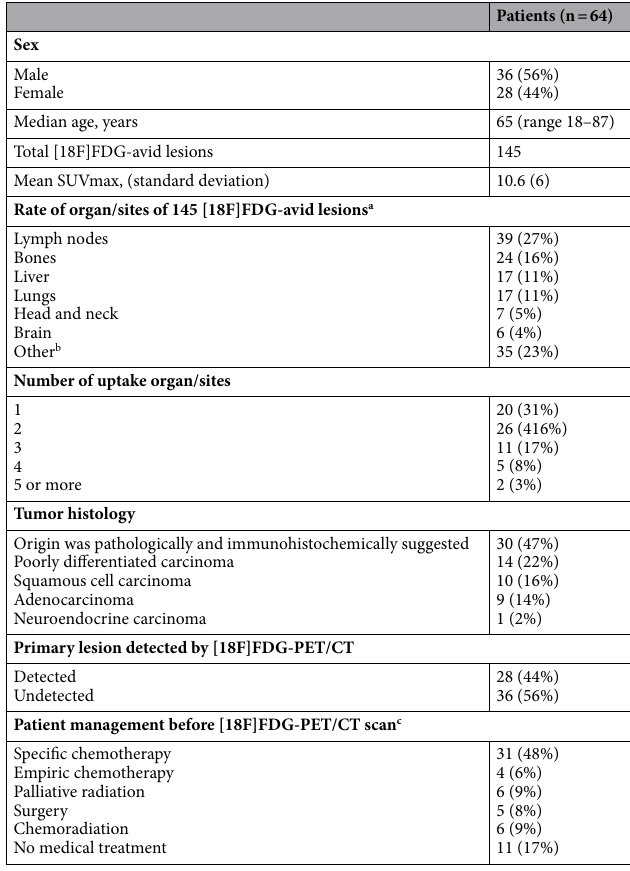
Table 1. Demographic, clinical and radiographic characteristics of the study cohort. a The total number of sites exceeds 100% due to the involvement of more than one site in some patients. b ‘Other’ includes the uro- gynecological system, esophagus, peritoneum, skin, colon, thyroid and muscles. c Number of patients